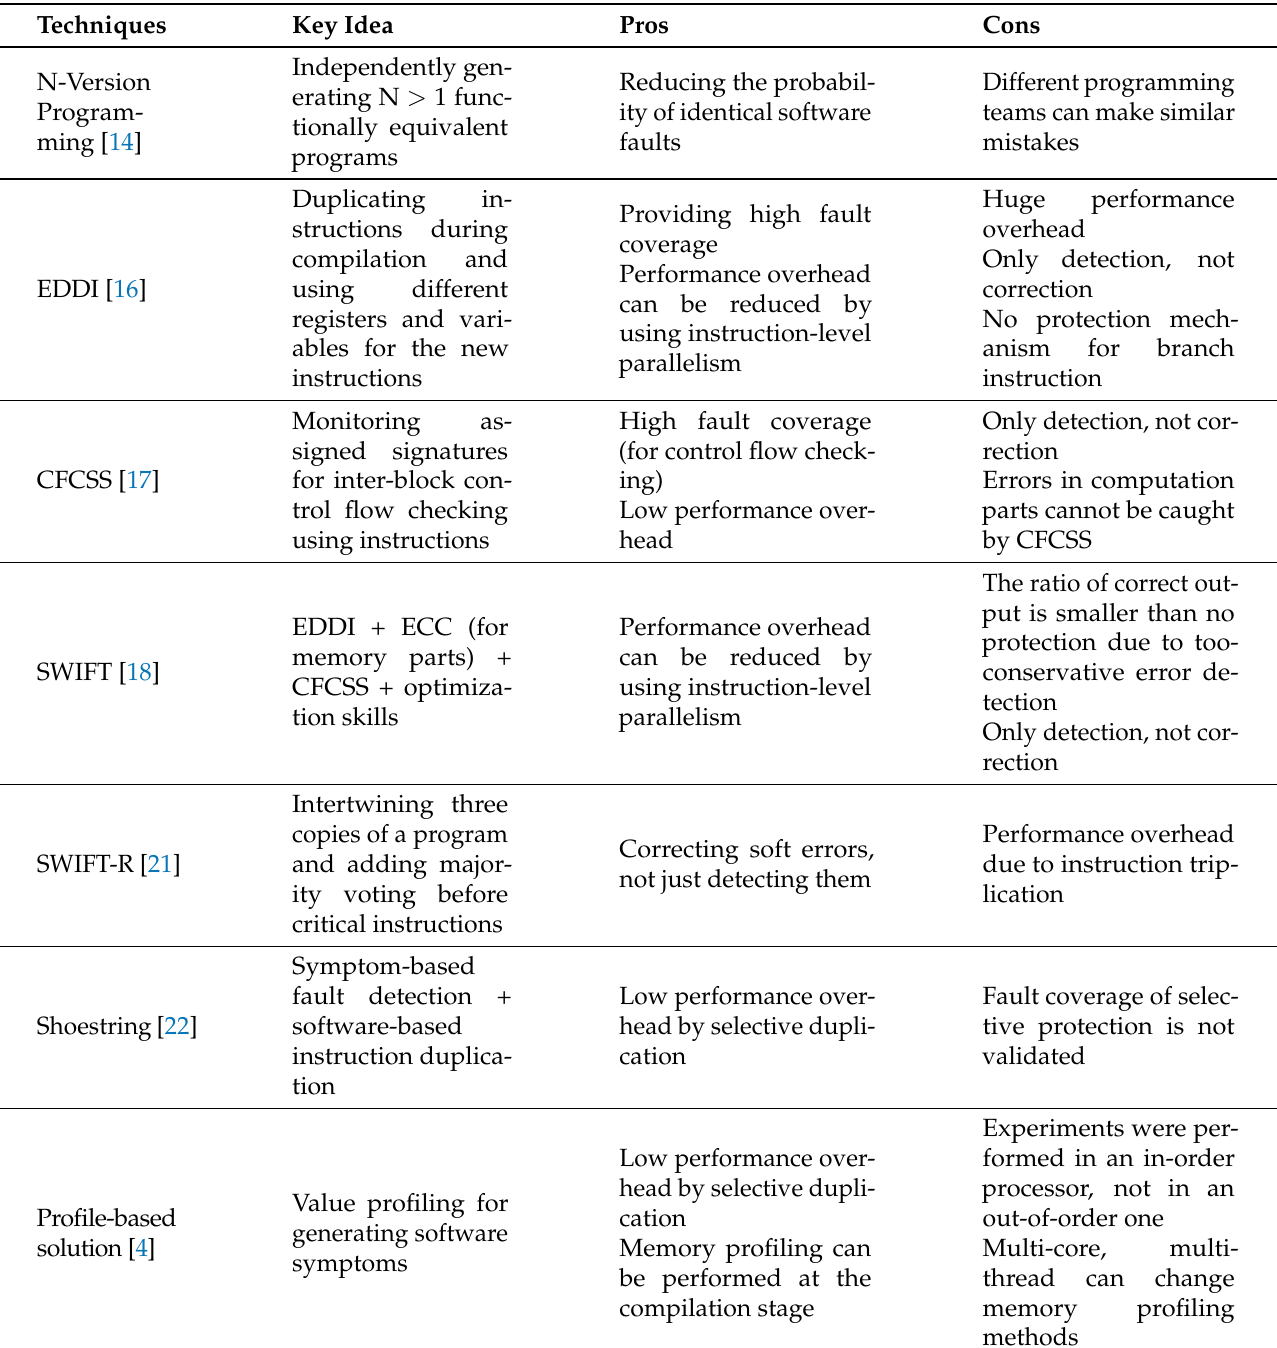
Table 1. Comparison between software-based protection techniques against soft